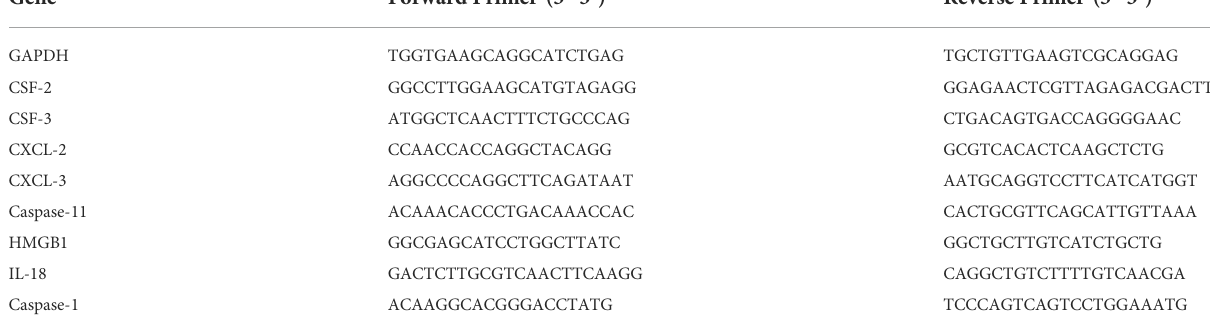
TABLE 1 The primer sequences for real-time